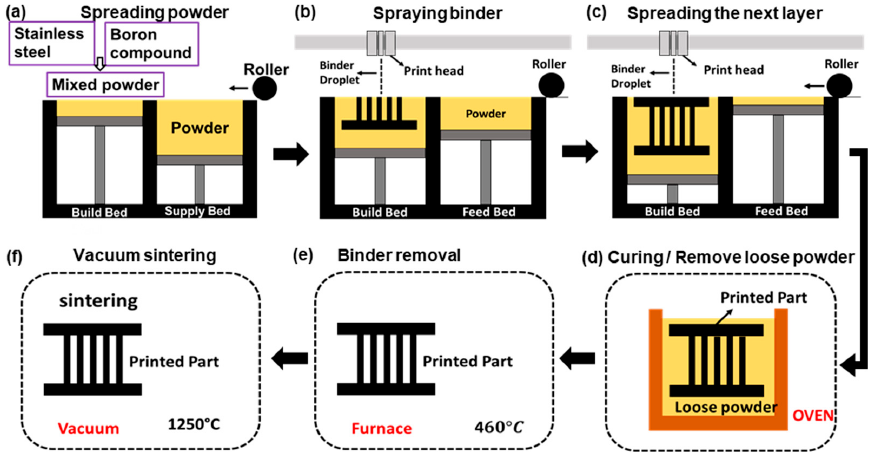
Figure 2. Schematics of the binder jet printing (BJP) process flow: ( a ) delivering and spreading stainless steel (SS) powder from the feed bed to the build bed, ( b ) spraying binder phase in the build bed according to the design, ( c ) delivering and spreading the next layer of SS powder and repeat ( b ) and ( c ) until the part is fully printed, ( d ) curing the part and remove loose powder, ( e ) burn out